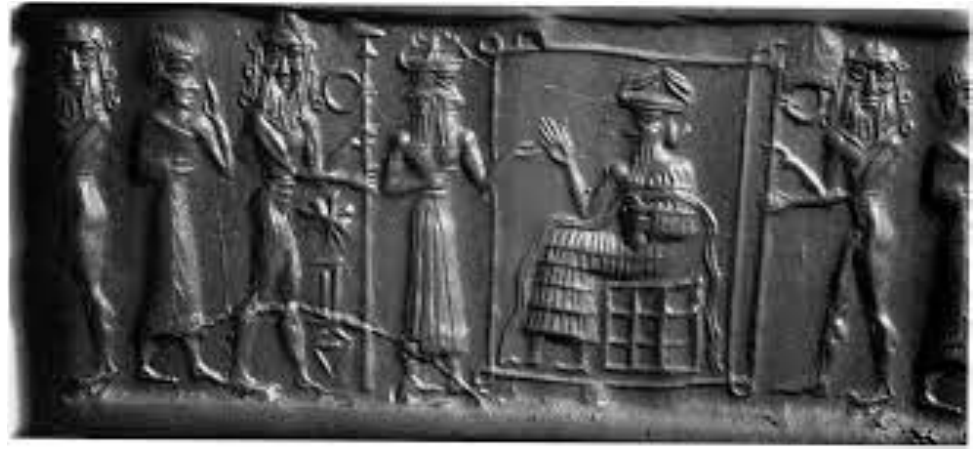
Figure 3. The Janus-faced god Usmû introducing a supplicant before the god Enki sitting in a shrine guarded on two sides by the lahmu , Old Akkadian Period (Adapted from ref. (Porada 1993, Figure 15)).